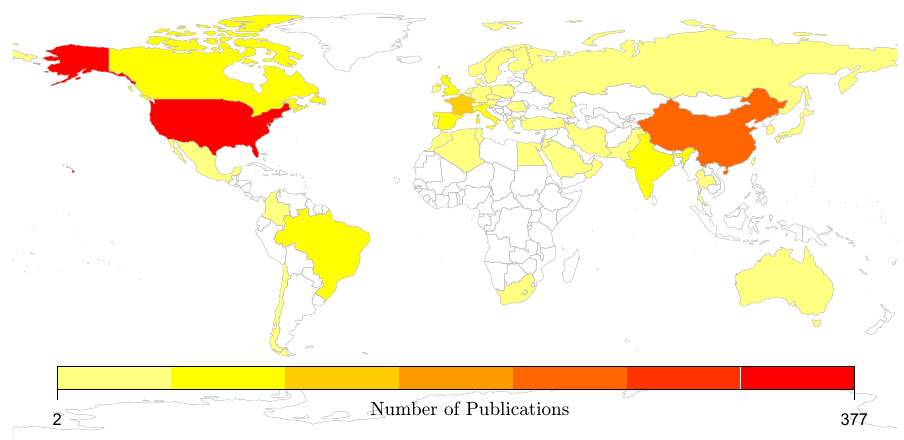
Figure 11. Published